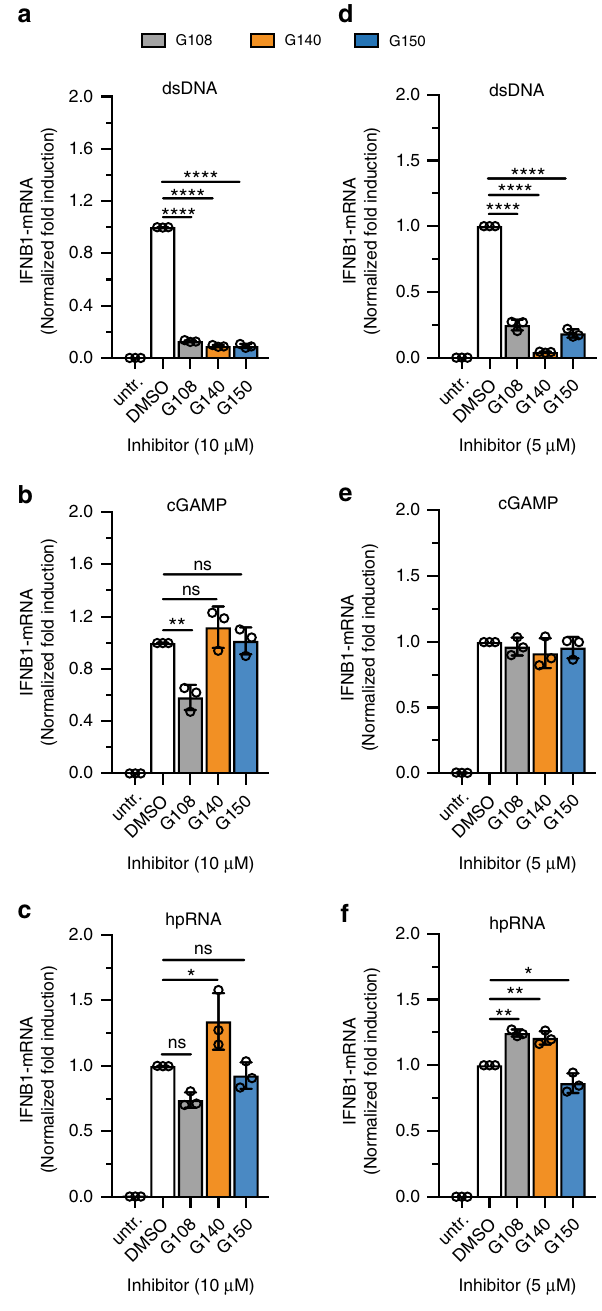
Fig. 7 G chemotype inhibitors show speci fi c inhibition against cGAS in human THP1 and primary human macrophages. a – c Speci fi city of G108 , G140 , and G150 against cGAS activity was tested using different ligands [2 µ g ml − 1 dsDNA (cGAS), 10 µ g ml − 1 cGAMP (STING), 0.5 µ g ml − 1 hpRNA (RIG-I)] for IFNB1 mRNA induction followed by any possible inhibition in the presence of 10 µ M inhibitor concentration in THP1 cells. d – f Speci fi city analysis of 5 µ M G108, G140 , and G150 against cGAS inhibition in primary human macrophage cells differentiated from human blood-derived monocytes using different ligands: 2 µ g ml − 1 dsDNA (cGAS), 10 µ g ml − 1 cGAMP (STING), or 0.5 µ g ml − 1 hairpin RNA (hpRNA) (RIG-I). Data shown are mean ± S.D. for three technical replicates and are representation of two independent experiments ( n = 3; mean ± S.D.; * p = 0.04, ** p < 0.01, ****p < 0.0001 using one-way ANOVA followed by Tukey ’ s test for multiple comparison ( a – d , f ). Data shown are representation of two independent